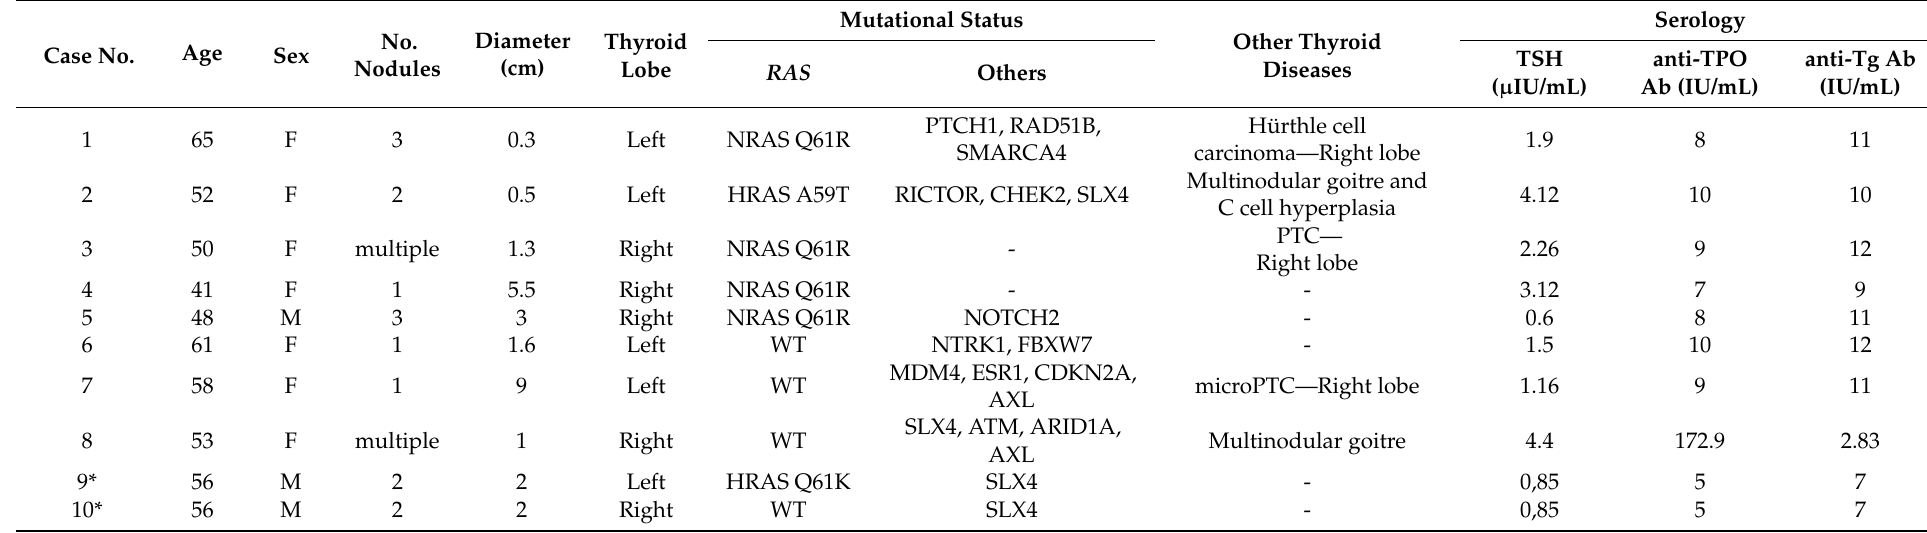
Table 1. Clinical, pathological and molecular characteristics of the cohort. *Single patient with bilateral